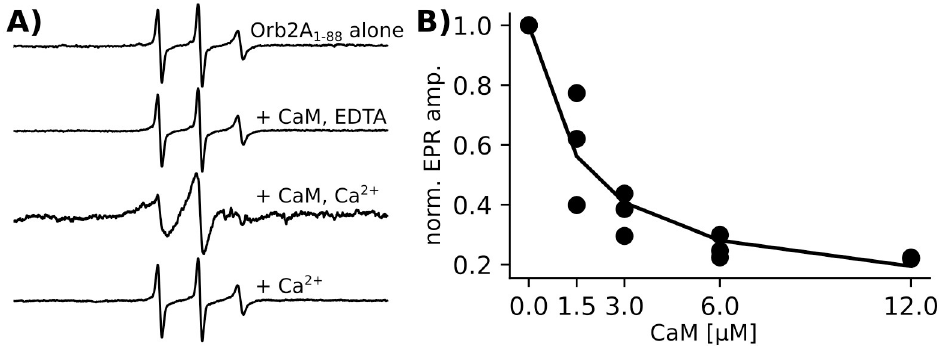
Fig 2. Activated CaM binds Orb2A 1-88 . A) EPR spectra of Orb2A 1-88 labeled at position 10 (10R1) show no change in linewidth with the addition of CaM together with EDTA or Ca 2+ alone. However, the linewidth increased with the addition of CaM together with Ca 2+ . CaM was added at a 2:1 molar ratio to Orb2A 1-88 , Ca 2+ and EDTA were added to a final concentration of 1 mM. EPR spectra intensity was normalized to their central linewidth. B) Change in EPR central line amplitude of 6 μ M Orb2A 1-88 10R1 with increasing concentrations of CaM. Ca 2+ was present in excess (10 mM). Three biological replicates are shown together with a fit to a one-site binding hyperbolic function to determine the dissociation